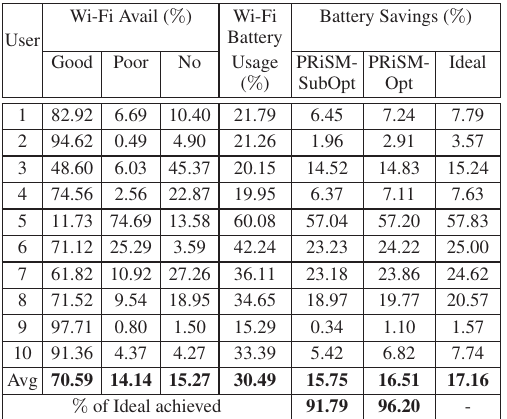
Table 4: Total Wi-Fi usage and battery savings for users in dataset ‘D2’ for Wi-Fi offloading with τ = − 80 dBm . Wi-Fi Avail ( % ) Wi-Fi Battery Savings ( % ) Battery User Good Poor No Usage PRiSM- PRiSM- Ideal ( % ) SubOpt Opt